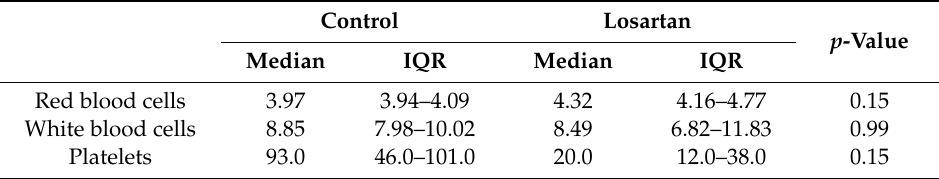
Table 3. Bone marrow aspirate comparison between control and losartan groups in complete blood count (CBC) values. Red blood cells were measured in M / uL, while white blood cells and platelets were measured in K / uL.